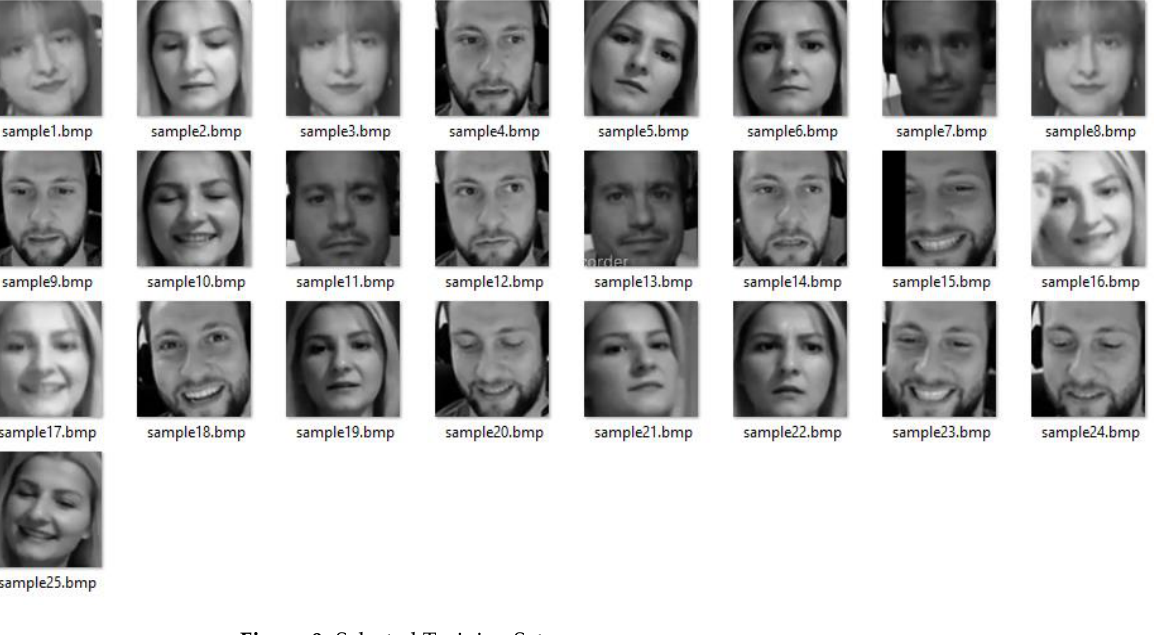
Figure 9. Selected Training Set.